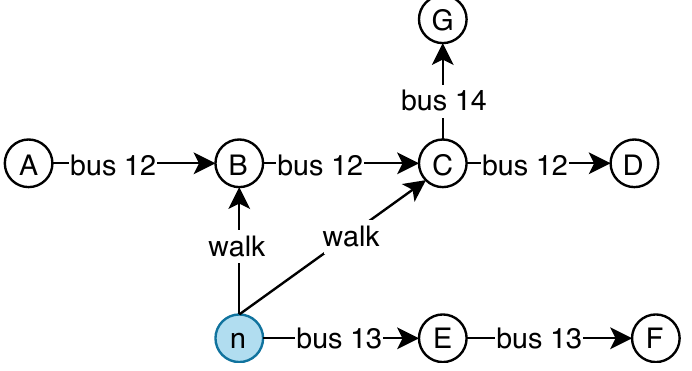
Figure 3. Example of arc